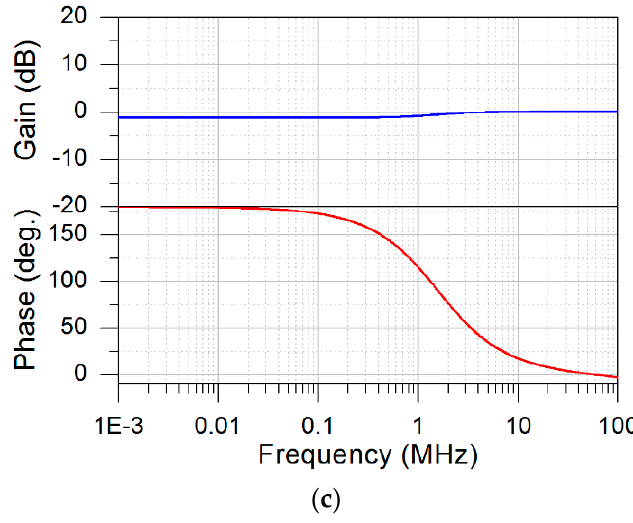
Figure 4. Frequency responses of gain and phase: ( a ) LP; ( b ) HP; ( c ) AP.